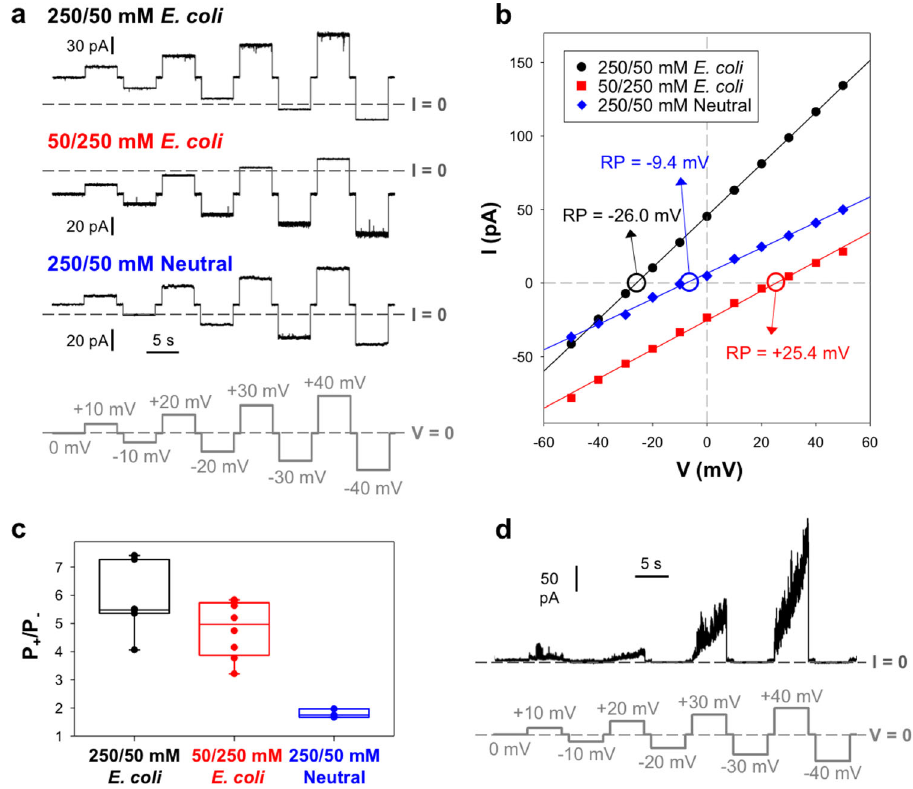
Fig. 5 Tse5-CT forms stable pores with ohmic behaviour and preference for cations, and some pores with noisy currents and strong voltage dependence. a Representative Tse5-CT-induced stable current traces were obtained in a 250/50 mM (upper panel) or 50/250 mM (middle panel) KCl gradient using a polar lipid extract from E. coli to form the membrane. The lower panel shows a representative trace in 250/50 mM KCl gradient when a neutral DOPE membrane was used. The applied voltages are shown at the bottom in light grey. b I / V curves corresponding to the traces shown in ( a ). Linear regressions (solid lines) allow calculation of the conductance (1.76 nS (black), 0.99 nS (red) and 0.95 nS (blue)) and reversal potential (RP, indicated by circles and arrows). A negative (positive) RP corresponds to a cation (anion) selectivity. c Permeability ratios, P K + /P Cl − , calculated from corresponding reversal potentials using the GHK equation 78 . Solid circles correspond to the individual data points. Data are means of 7 (black), 8 (red), and 4 (blue) independent experiments. d Representative Tse5-CT-induced noisy current trace was obtained in a 250/50 mM KCl gradient using the E. coli polar lipid extract to form the membrane. The applied voltage is shown at the bottom in light grey. Current records in ( a ) and ( d ) were digitally fi ltered with 500 Hz using a low-pass 8-pole Bessel fi lter for better